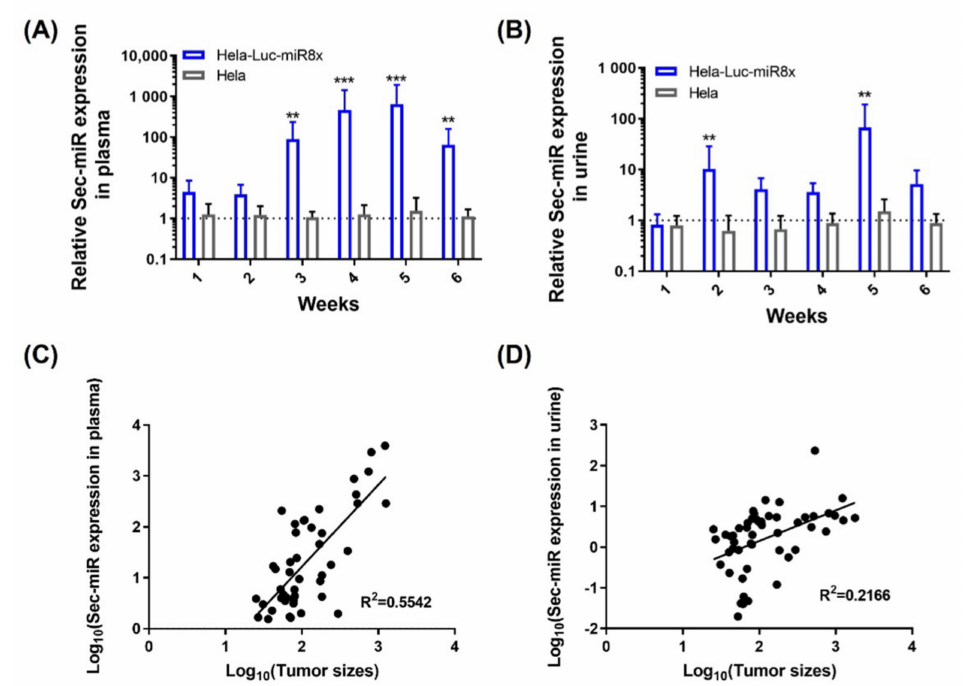
Figure 2. Sec-miR is detectable in the blood and urine of mice bearing Sec-miR-expressing Hela tumors and can be used as a complement to imaging reporters. Both parental Hela and the Hela cells stably express Luc2 and 8 copies of Sec-miR (Sec-miR 8X) were inoculated to mice; blood and urine of these tumor-bearing mice were collected and analyzed. Blood samples were collected once a week after the average tumor size reached 150 mm 3 . ( A ) Significantly higher Sec-miR expressions were detected in blood from mice with Hela/EF1-Luc2-Sec-miR 8X tumors, and the Sec-miR expression increased as the tumors grew. ( B ) Detectable Sec-miR expressions were found in urine from the mice with Hela/EF1-Luc2-Sec-miR 8X tumors from week 2 after tumor inoculation. The Sec-miR expressions did not increase as the tumor grew but varied over time. Correlations of tumor sizes and Sec-miR expressions in ( C ) blood and ( D ) urine. Data from Hela/EF1-Luc2-Sec-miR 8x mice are normalized to data from parental HeLa mice and expressed as mean ± SD. **, p < 0.01; ***, p <